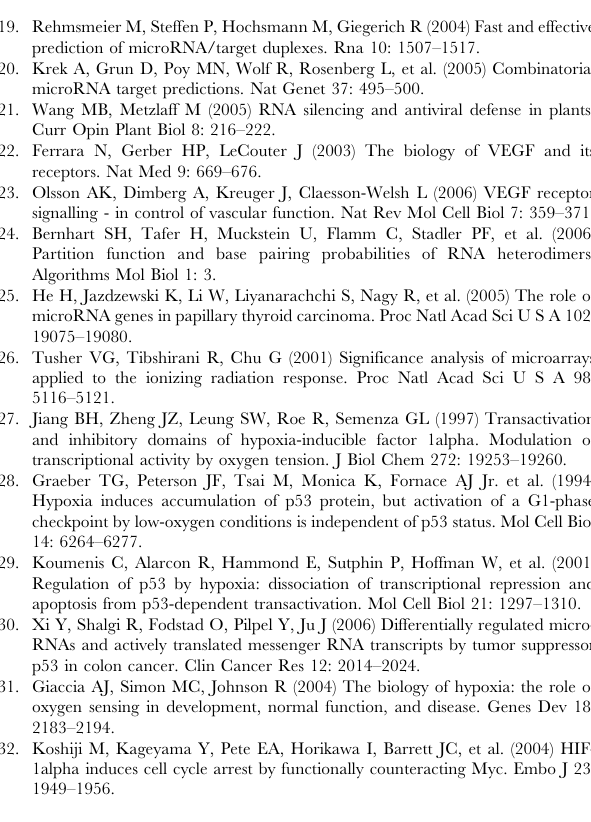
Figure S1 Image of miRNA microarray. miRNA array analysis was performed with mRNA samples from hypoxia-induced CNE cells (A and B) and non-induced CNE cells (C and D). An miRNA microarray chip containing 509 probes in triplicate was used in the